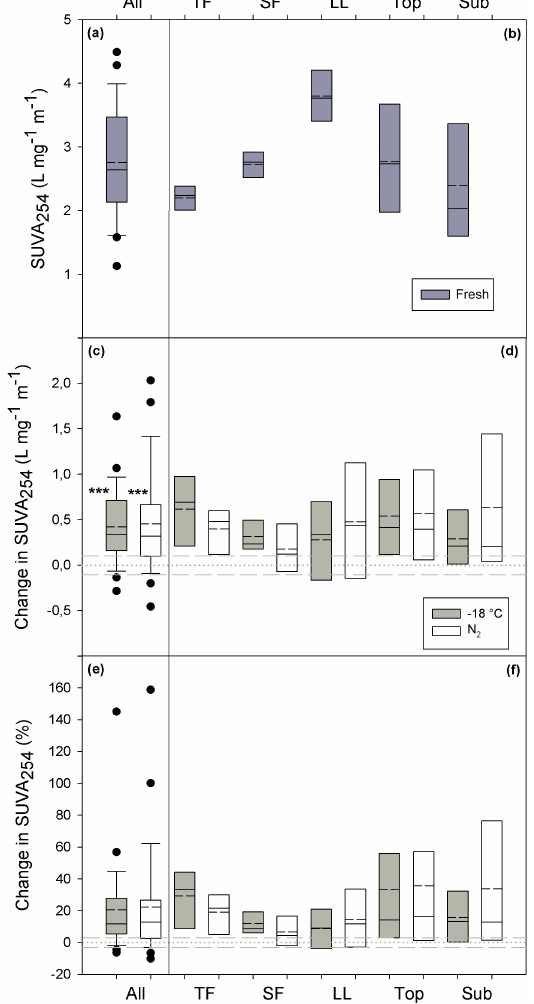
Figure 5. Absolute values (measured in fresh samples) and changes of HIX after freezing ( − 18 ◦ C) and fast-freezing with liquid nitro- gen; (a, c, e) all samples ( n = 27); (b, d, f) ordered by sample type (throughfall (TF) n = 6, stemflow (SF) n = 5, litter leachate (LL) n = 5, top soil solution (Top) n = 6, sub-soil solution (Sub) n = 5); gray dashed line: analytical reproducibility; ∗∗∗ significant changes (linear mixed models (lme), p< 0.05); boxplots: solid line: median, dashed line: